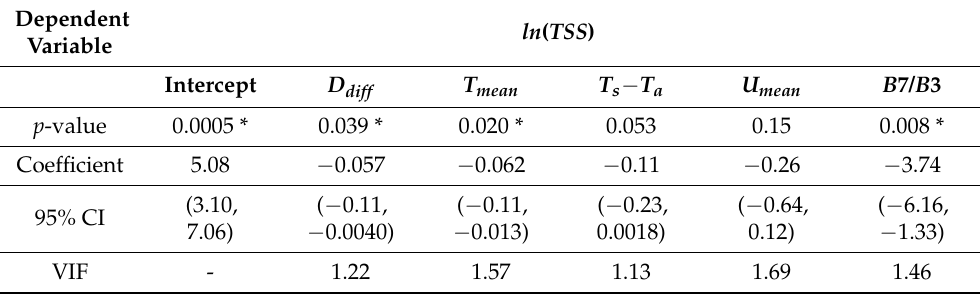
Table 5. Statistical model to predict TSS concentration from remotely sensed data. Dependent